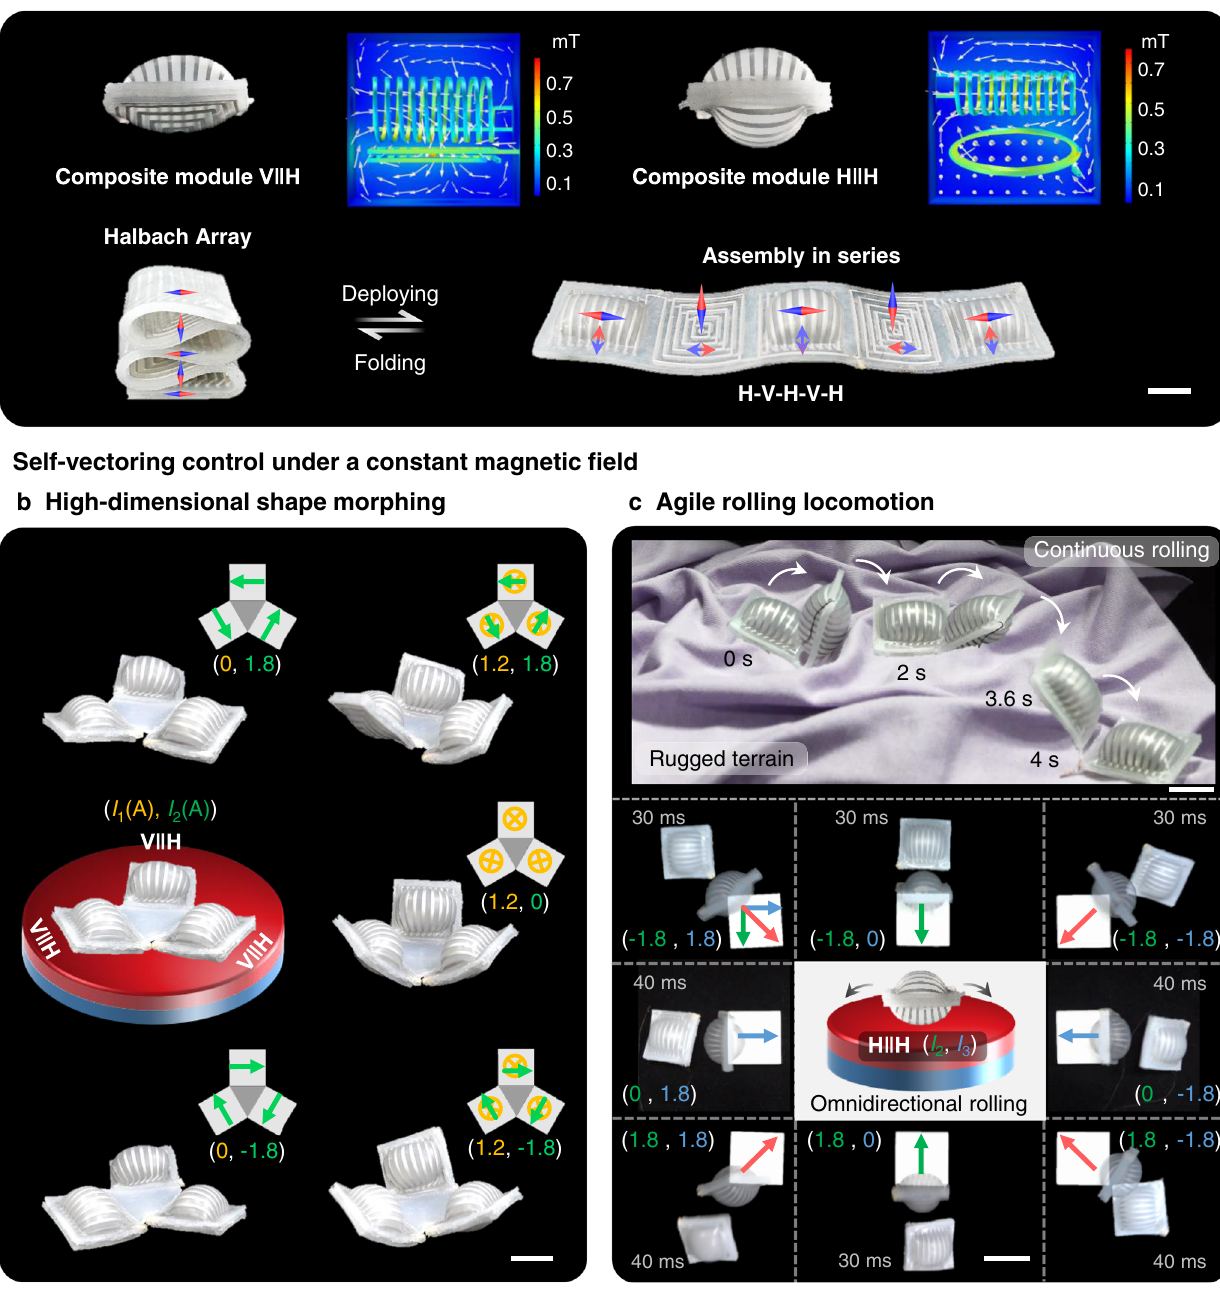
Fig. 2 | Different con fi gurations of SESR prototypes and self-vectoring control underaconstantmagnetic fi eld.a EVsynthesisanddifferentcombinationsofthe two soft fl ux actuator modules. Combining module H with module V or another moduleH in parallel can generate twoelementary composite modules, referred as V||H and H||H, respectively. A soft Halbach Array is fabricated by connecting multiple H and V modules alternately in series, which can be folded and deployed. Scale bar=10mm. b High-dimensional shape morphing of a trefoil-shaped SESR